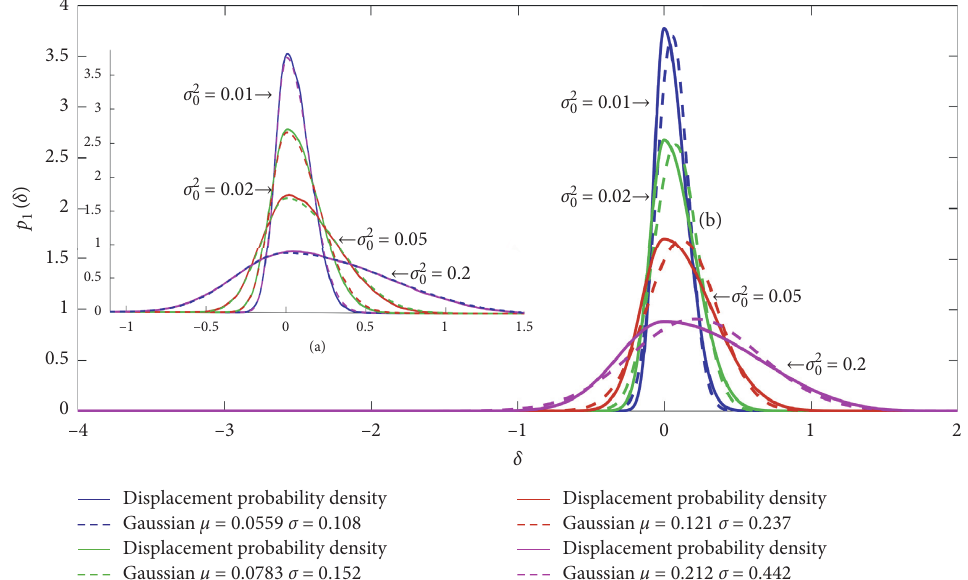
Figure 5: Displacement PDFs of ATNPS for various values of excitation grades. (a) Comparison of the numerical and theoretical solution. (b) The result of Gaussian fitting.